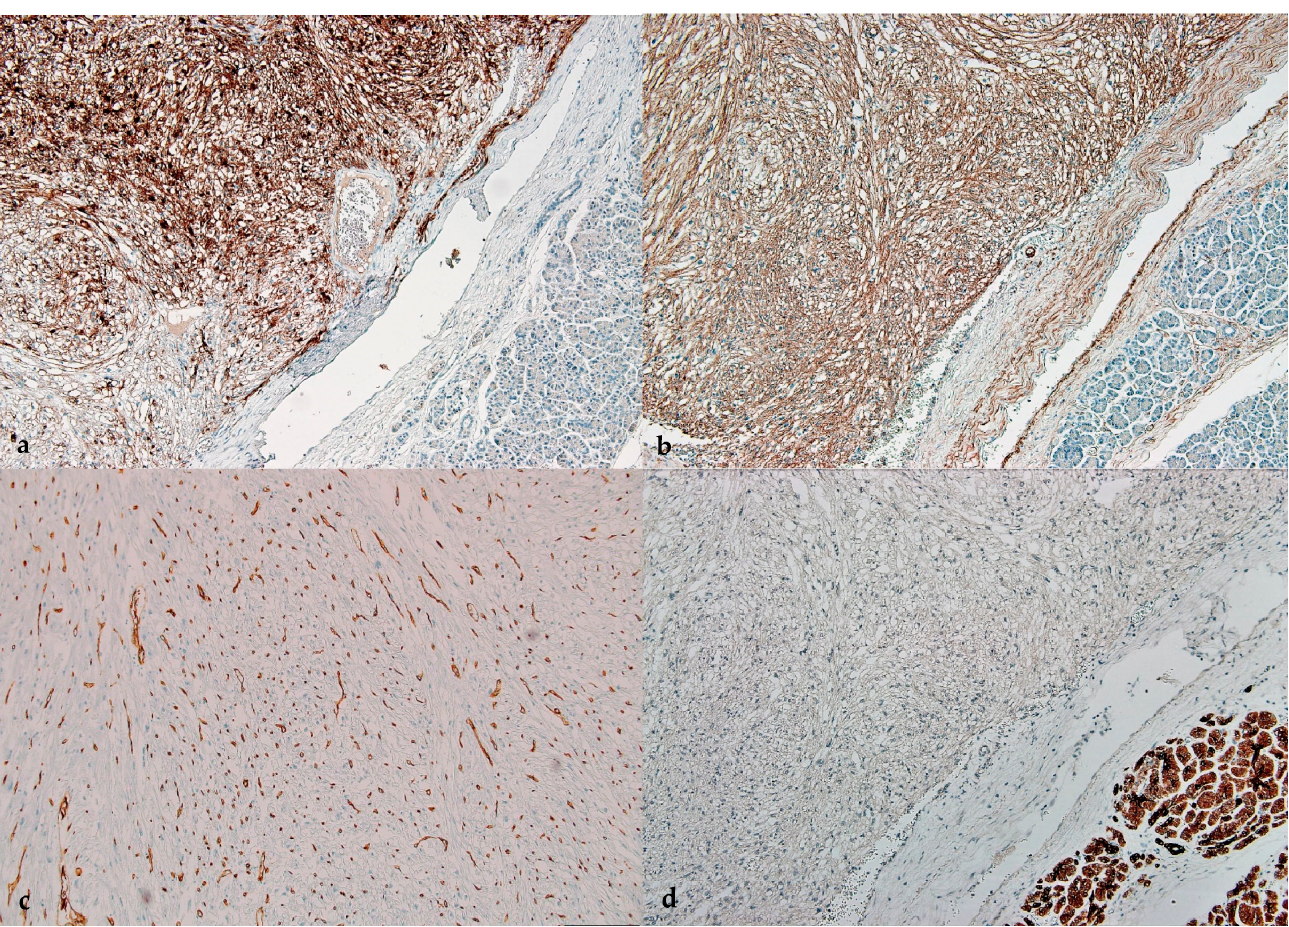
Figure 3. Immunohistochemical stains. HMB45s show positive staining of tumor cells. Normal pan- creatic acini show negative staining ( a ); smooth muscle actine (SMA) shows positive staining tumor cells. Normal pancreatic acini show negative staining ( b ); CD34 demonstrating rich vascularity of the tumor, with perivascular epithelioid cells closely related to the capillaries ( c ); and pancytokeratin shows positive staining of normal pancreatic acini, and negative staining of tumor cells ( d ).